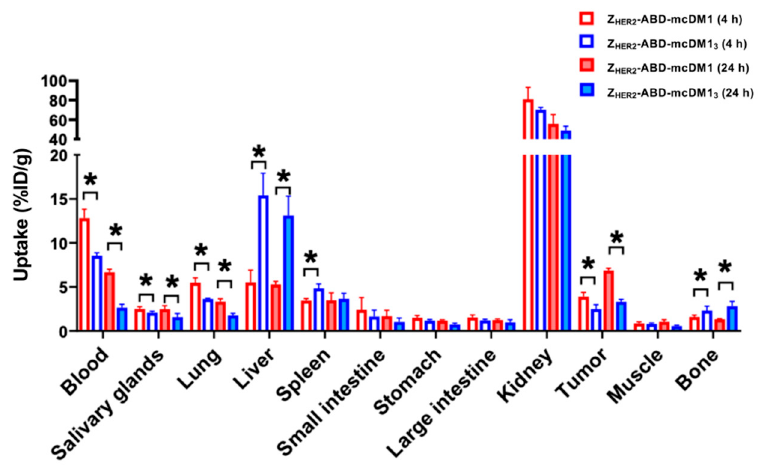
Figure 7. Biodistribution of Z HER2 –ABD–mcDM1 and Z HER2 –ABD–mcDM1 3 in female BALB/c nu/nu mice bearing human SKOV3 xenografts with high HER2 expression. The biodistribution was determined at 4 h (hollow bars) and 24 h (solid bars). The total injected mass was 6 µg/mouse. The data are presented as the mean values ( n = 3–4) ± 1 SD. The star signs (*) correspond to significant differences ( p < 0.05).